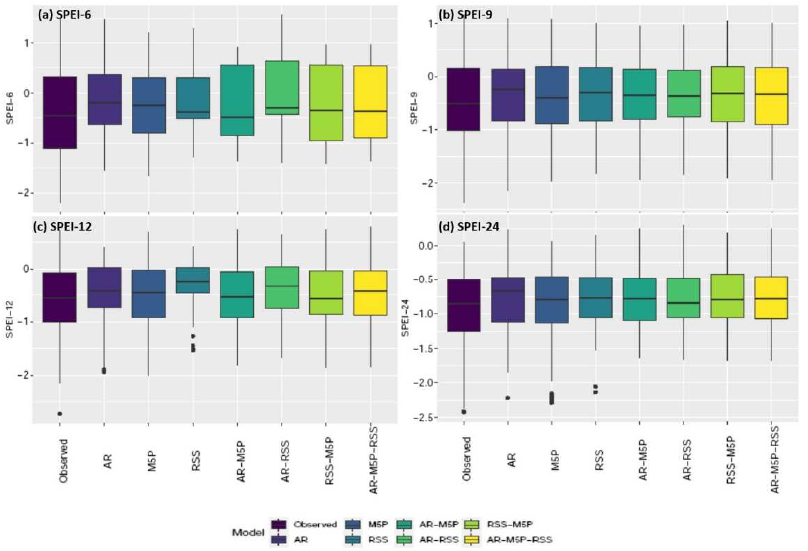
Figure 6. Predictive model performance at Rajshahi station over multiple time scales during the testing period, ( a ) SPEI-6, ( b ) SPEI-9, ( c ) SPEI-12, ( d ) SPEI-24.